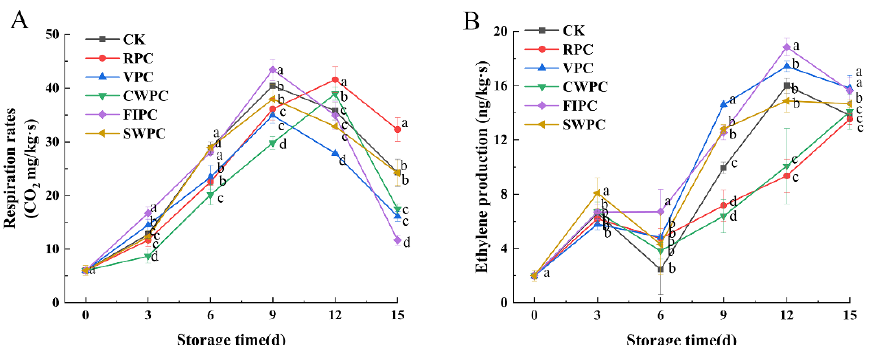
Figure 1. Changes in ( A ) respiration-rate and ( B ) ethylene production of yellow peaches under different precooling methods during cold storage. The abbreviations CK, RPC, CWPC, SWPC, FIPC, and VPC in the figure correspond to control group, refrigerator precooling, cold-water precooling, strong-wind precooling, fluidized-ice precooling, and vacuum precooling, respectively. Values with different lowercase letters in the same column are significantly different ( p < 0.05).